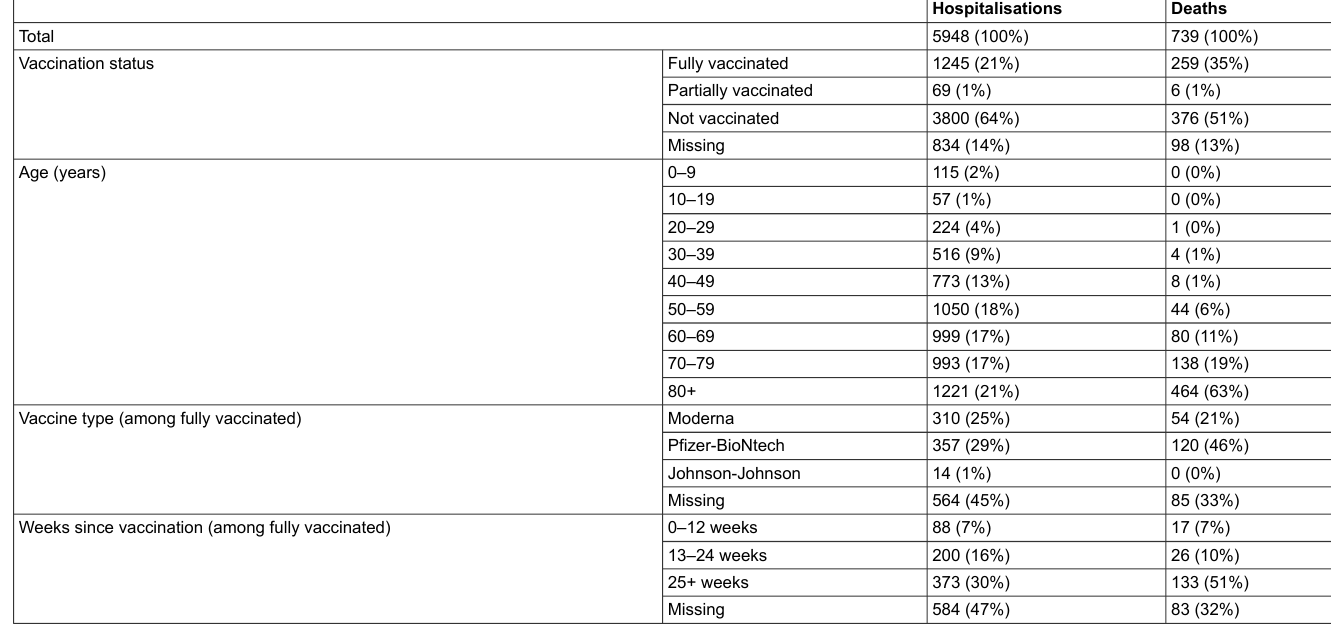
Table 1: Description of included COVID-19-related hospitalised and deceased persons from 1 July to 1 December